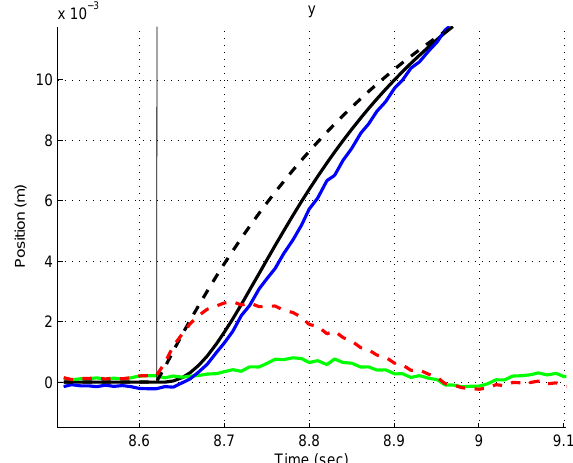
Figure 4: Transient response. Blue: measurements, Black: second order model, Green: error second order model, Dashed: proportional model, Red: error proportional model.